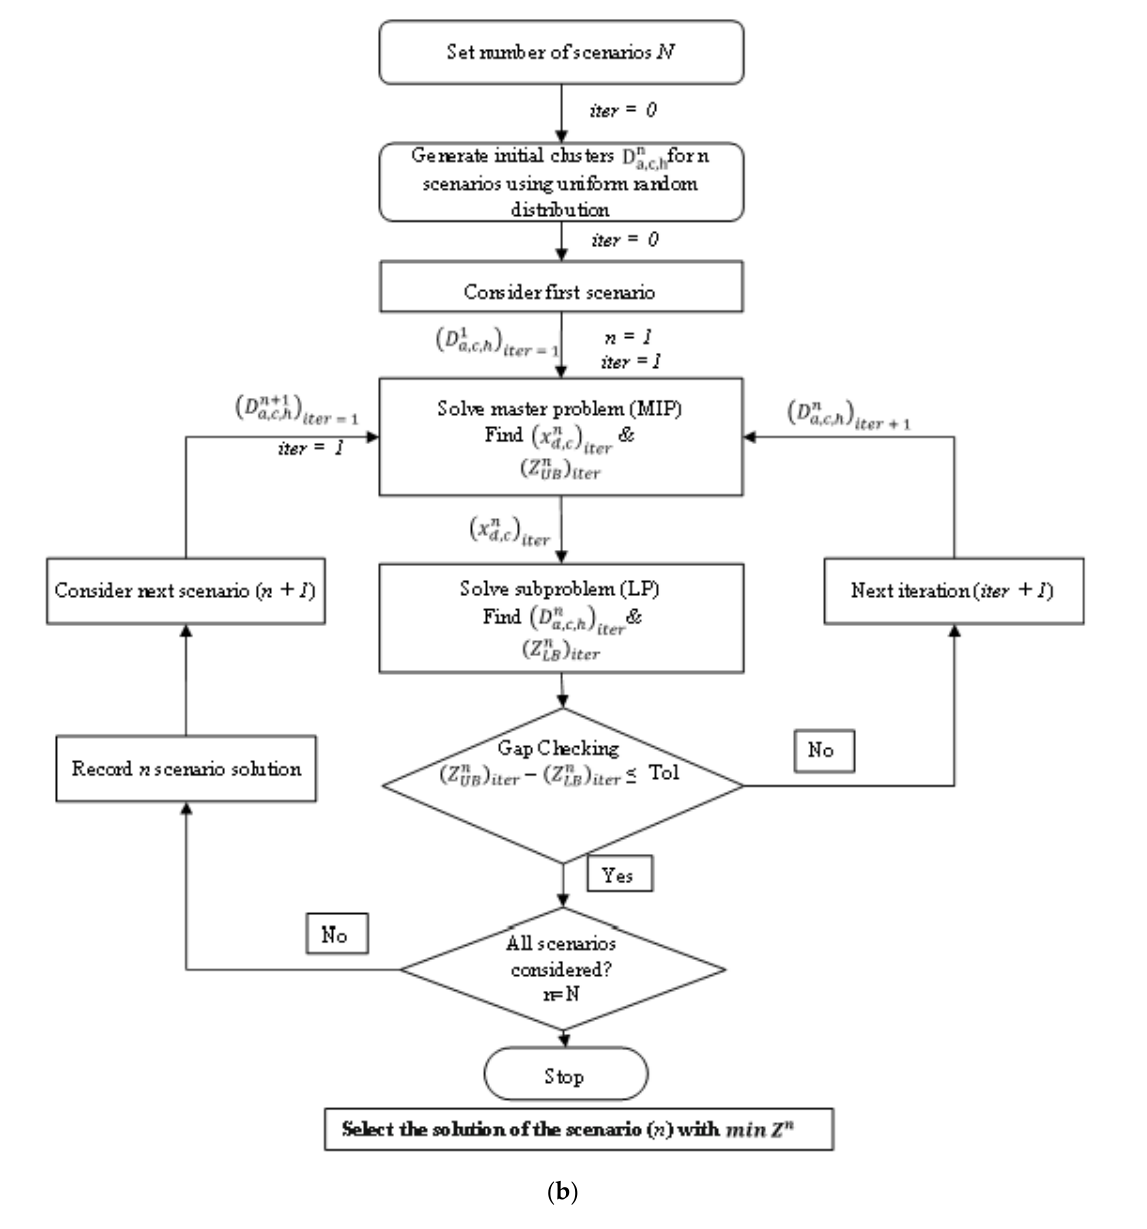
Figure 3. ( a ) Multiple attributes heuristic algorithm flow diagram for the given weight factor com- bination and Pareto frontier construction, ( b ) multiple attributes heuristic algorithm flow diagram for each initial guess scenario.